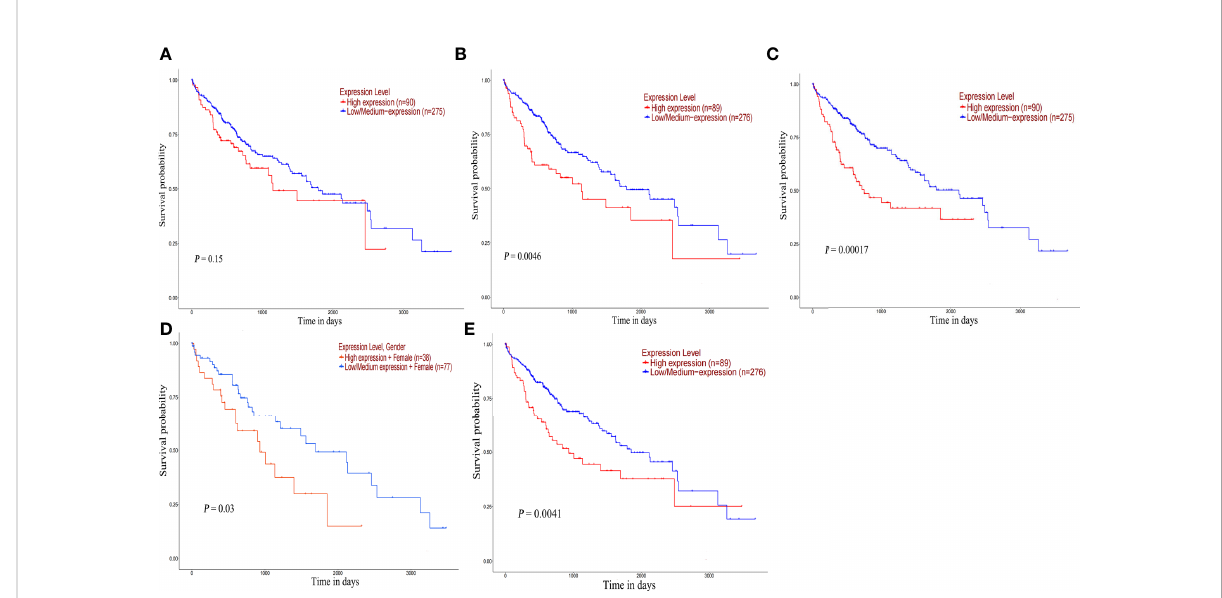
FIGURE 9 Overall survival analysis of hub genes. Survival curve for POLR2A (A) , POLR2B (B) , RPL5 (C) , RPS6 (D) and RPL23A (E) in HCC patients from TCGA database. The expression data were analyzed using log-rank